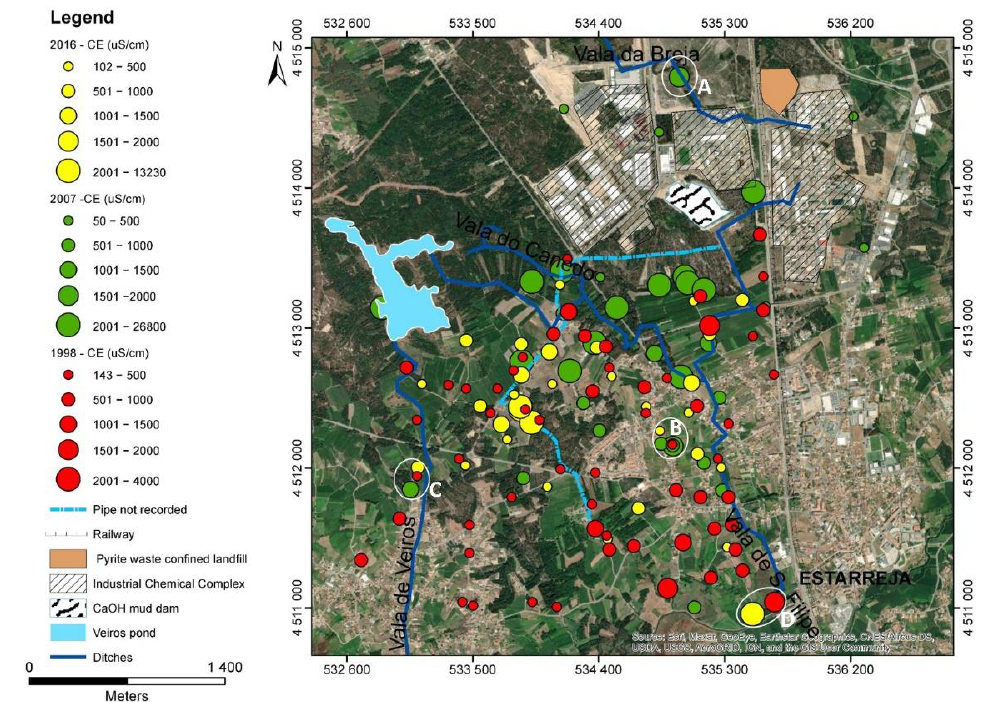
Figure 7. Spatial distribution of electrical conductivity values in the studied area (map coordinates: UTM; WGS84 — 29N zone).